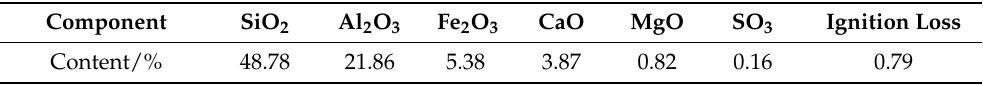
Table 1. Main chemical components of spontaneous combustion coal gangue obtained from a mine in Fuxin. Table 2. Main physical indexes of spontaneous combustion coal gangue in Fuxin.